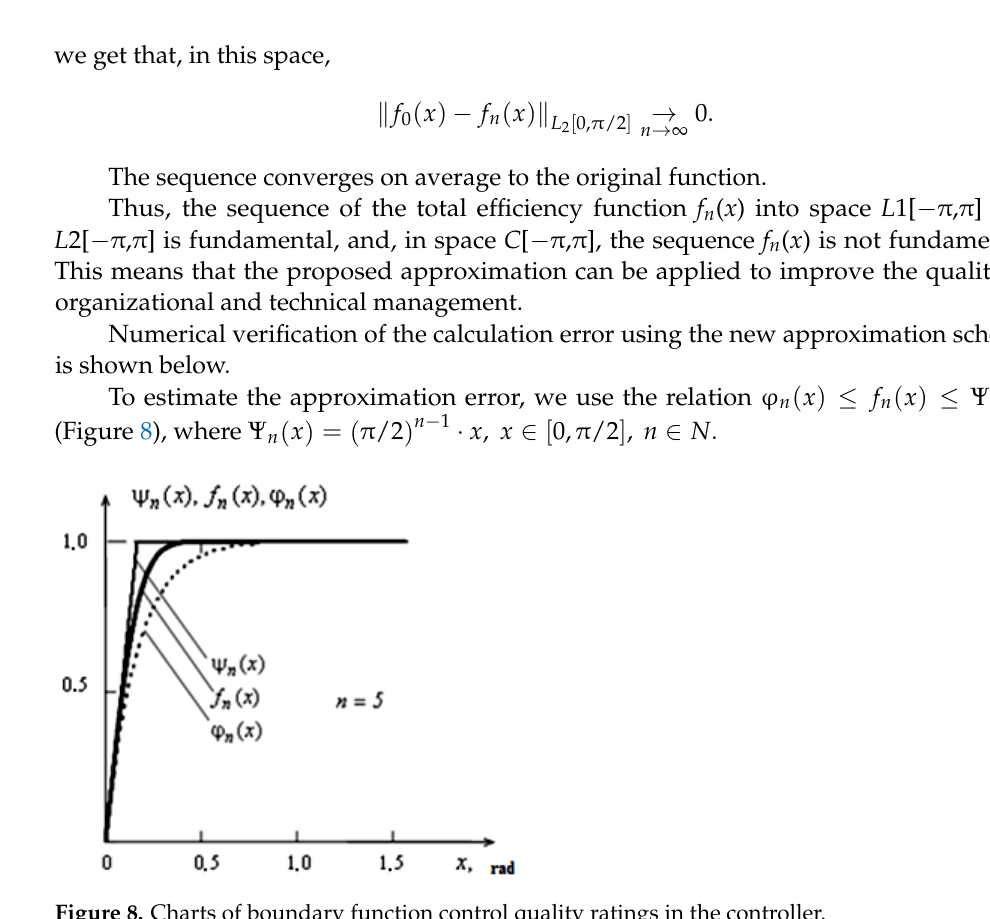
Figure 8. Charts of boundary function control quality ratings in the controller.